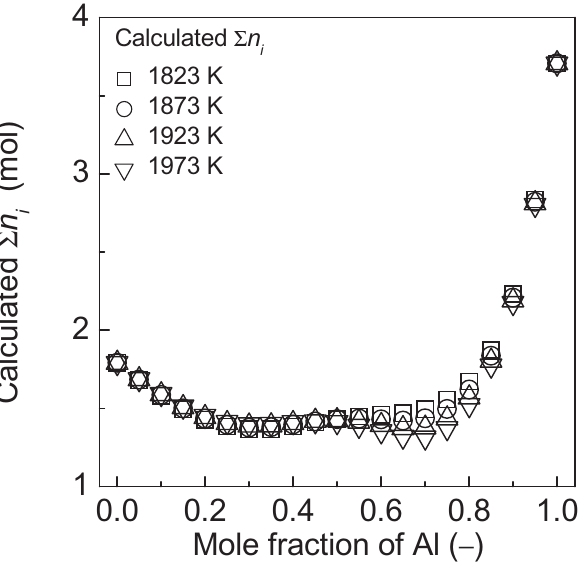
Figure 18: Relationship between mole fraction x Al of Al and calcu- lated total equilibrium mole number Σ n i in 100g Fe – Al binary melts by developed AMCT – N i model for Fe – Al binary melts at four tem- peratures of 1823, 1873, 1923, and 1973 K (1550, 1600, 1650, and 1700°C),